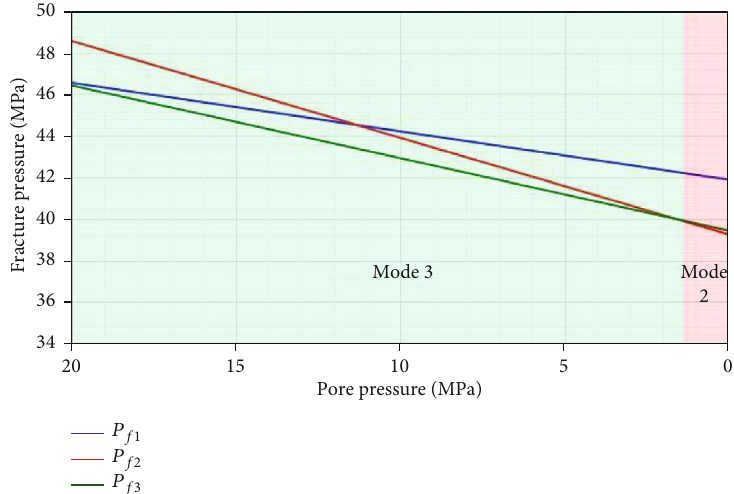
Figure 4: Change of fracture mode and fracture pressure with reservoir depletion of vertical wellbore drilled in strike fault stress regime.